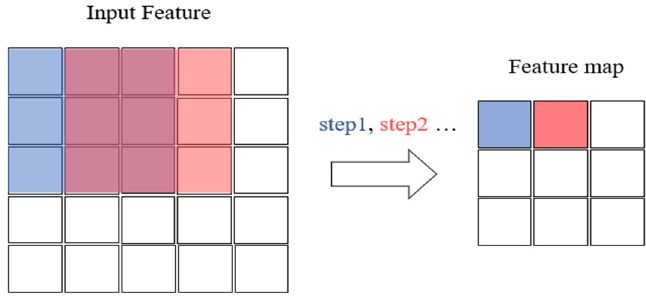
Figure 5. Simplified procedure of CNN feature mapping.